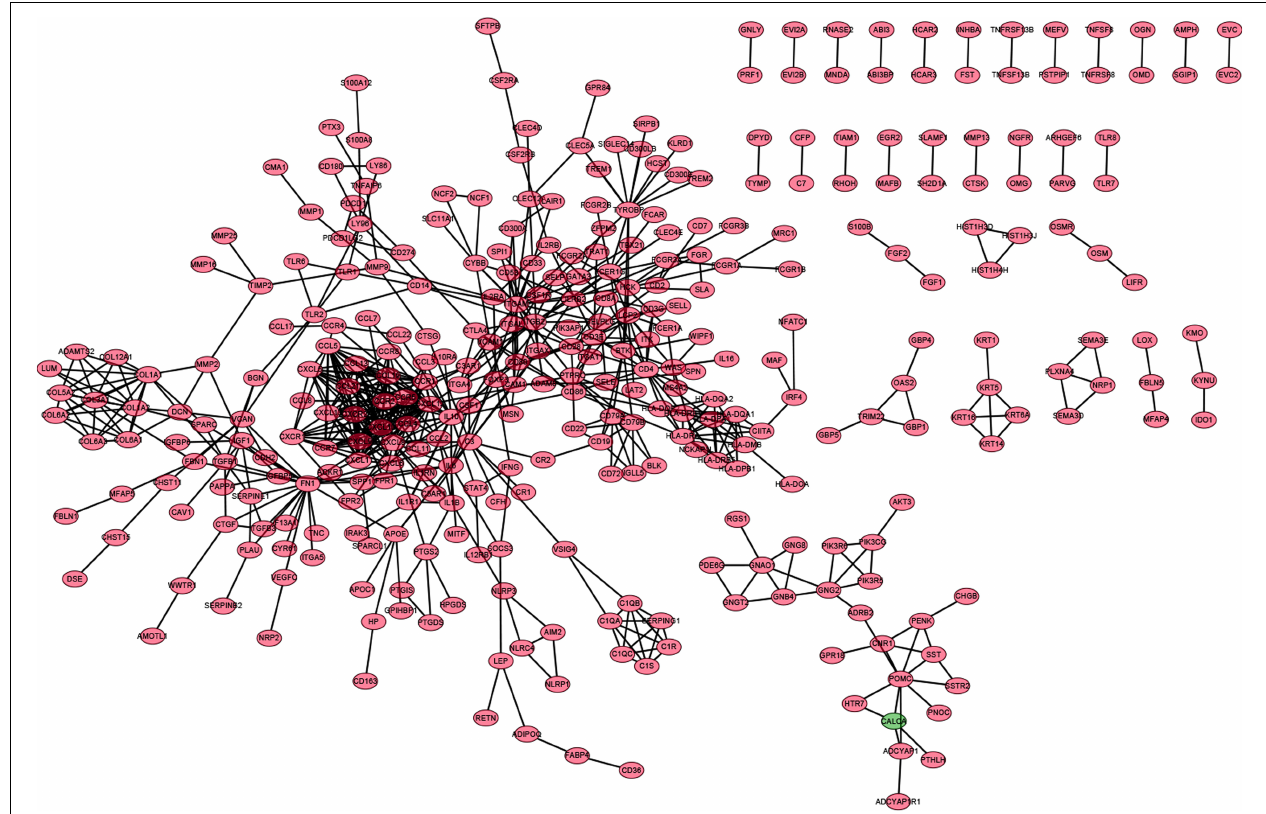
FIGURE 4 | PPI network of DEGs. PPI network was carried out with the nodes with interaction confidence value > 0.95.